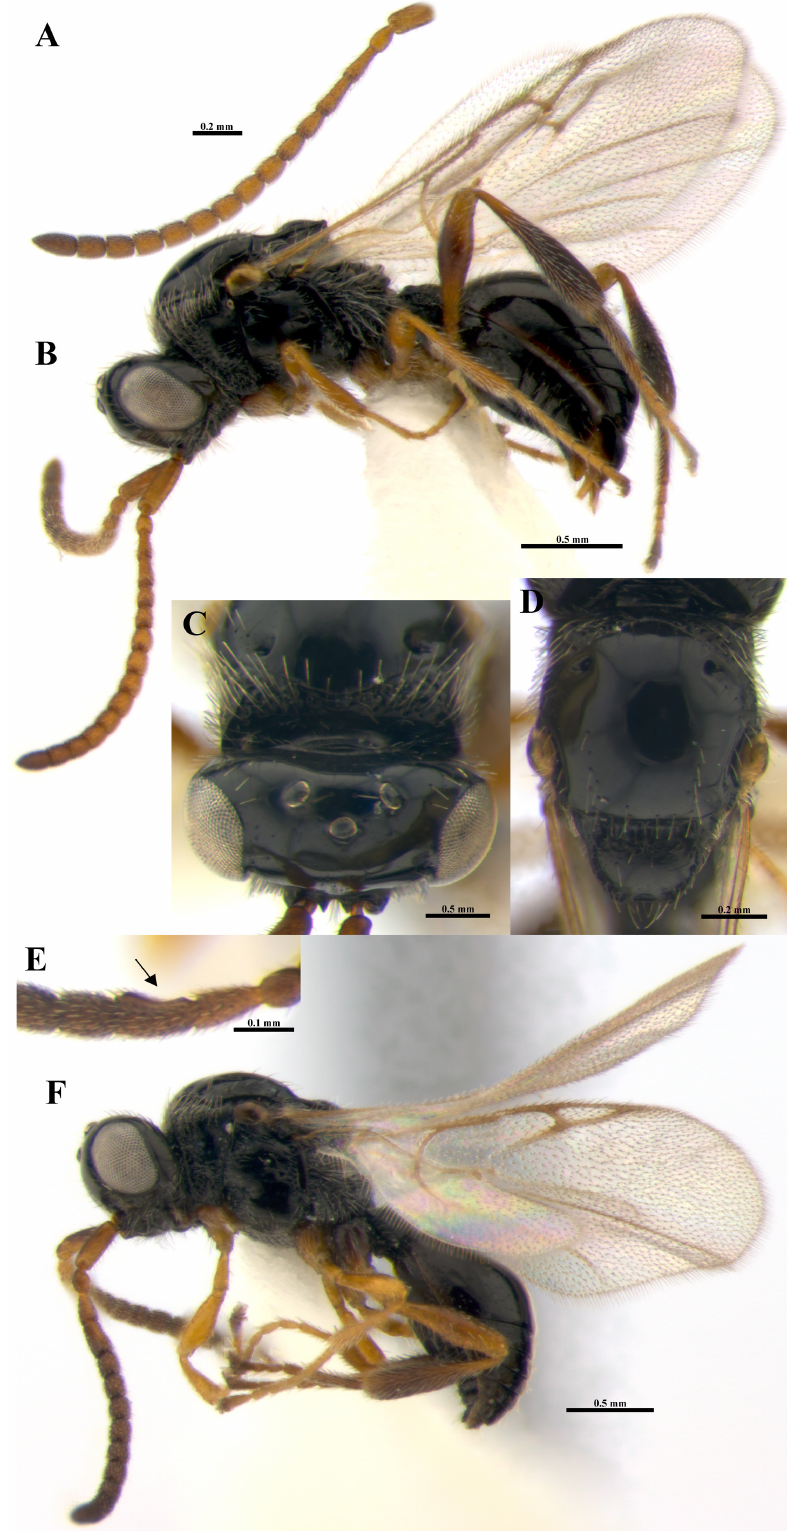
Fig. 5. Ismarus excavatus Kim & Lee sp. nov. (A–D. Holotype, ♀; E–F. Allotype, ♂). A . Antenna. B . Habitus in lateral view. C . Head in dorsal view. D . Mesosoma in dorsal view. E . Antenna (A3–A5). F . Habitus in lateral